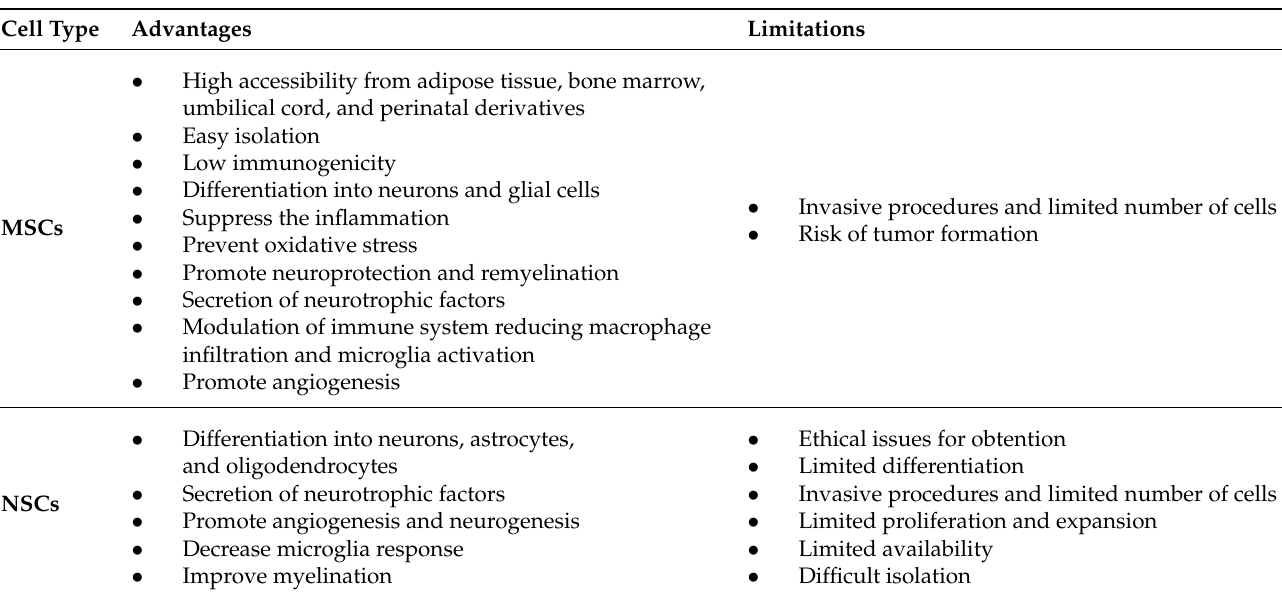
Table 1. Cell Types Used In The Intranasal